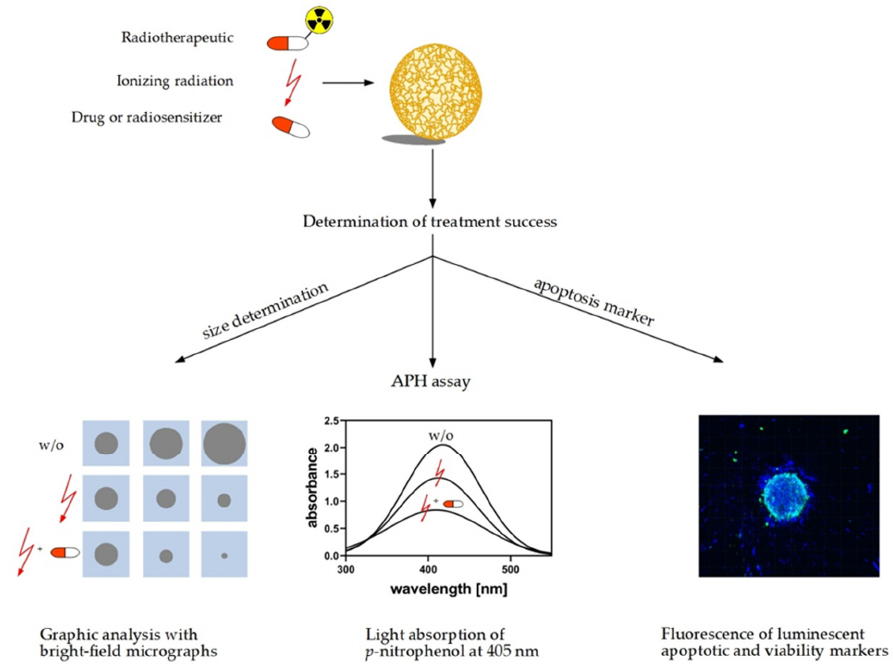
Figure 4. Methods for measuring response of spheroids to anticancer treatment: reactions of spheroids to treatments, e.g., irradiation, radiopharmaceuticals, or nonradioactive compounds, can be determined using these methods. The first option is to measure spheroid size using bright-field microscopy. Treatment effects are evaluated referring to shrinkage in size, reduction of growth rate, and capacity for regrowth (w/o: without). The second option is the acid phosphatase assay (APH) assay utilizing the activity of acid phosphatase in viable cells. The hydrolysis of p -nitrophenyl-phosphate to p -nitrophenol is detected as increase in absorption at 405 nm. The third option is to estimate the fraction of viable cells in a spheroid referring to staining of nucleic acids and viability markers such as DAPI and calcein,